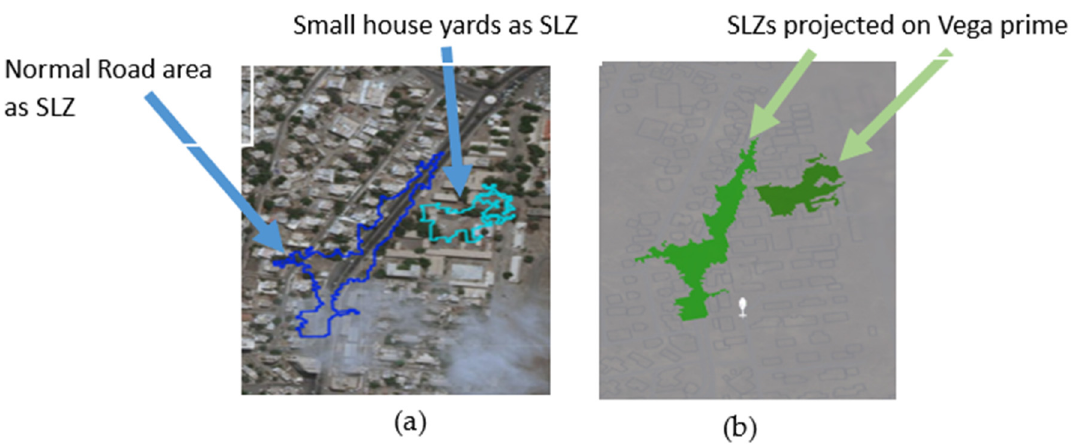
Figure 8. Safe Landing Zones (SLZ) of Scene 2 projected ( a ) on a two-dimensional aerial map and ( b ) on the Vega Prime platform for developing interactive 3D simulations & visualizations.